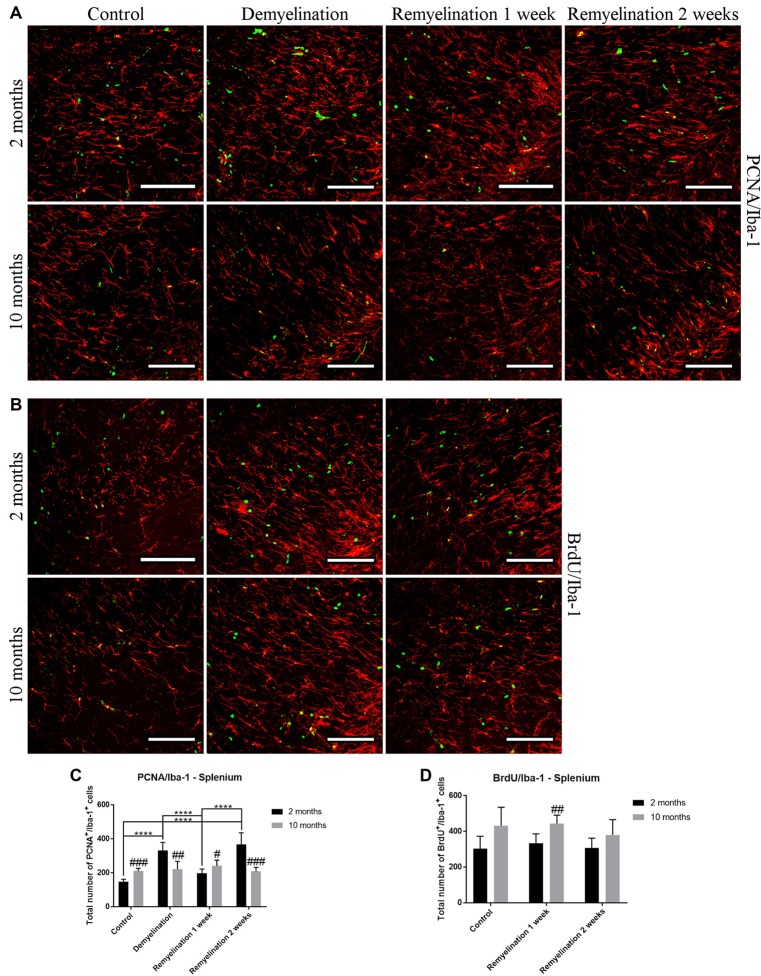
Age-related differences in the number of proliferating microglia (PCNA+ and BrdU+) in the splenium of the CC. (A) PCNA (green) and Iba-1 (red) labeling. (B) BrdU (green) and Iba-1 (red) staining. (C) The number of proliferating PCNA+ microglia was significantly increased in the middle-aged control group compared to the younger one. In young mice, there was a significant increase in PCNA+ microglia after demyelination and 2 weeks of remyelination. Thus, age-related differences in PCNA+ Iba-1+ cell numbers were found in all treatment groups. (D) The number of BrdU+ microglia was higher in the middle-aged group after 1 week of remyelination (a similar tendency was also observed in the other two groups). De- or remyelination did not affect the number of BrdU+ Iba-1+ microglia. Values are shown as means + SD (n = 6 per group). Statistical significance was evaluated using a two-way ANOVA and a Tukey’s post hoc test. The p-values are indicated in the graphs: treatment effects within the same age group: ****p < 0.0001, age-related differences: #p < 0.05, ##p < 0.01 and ###p < 0.001. Bars: (A) 100 μm.